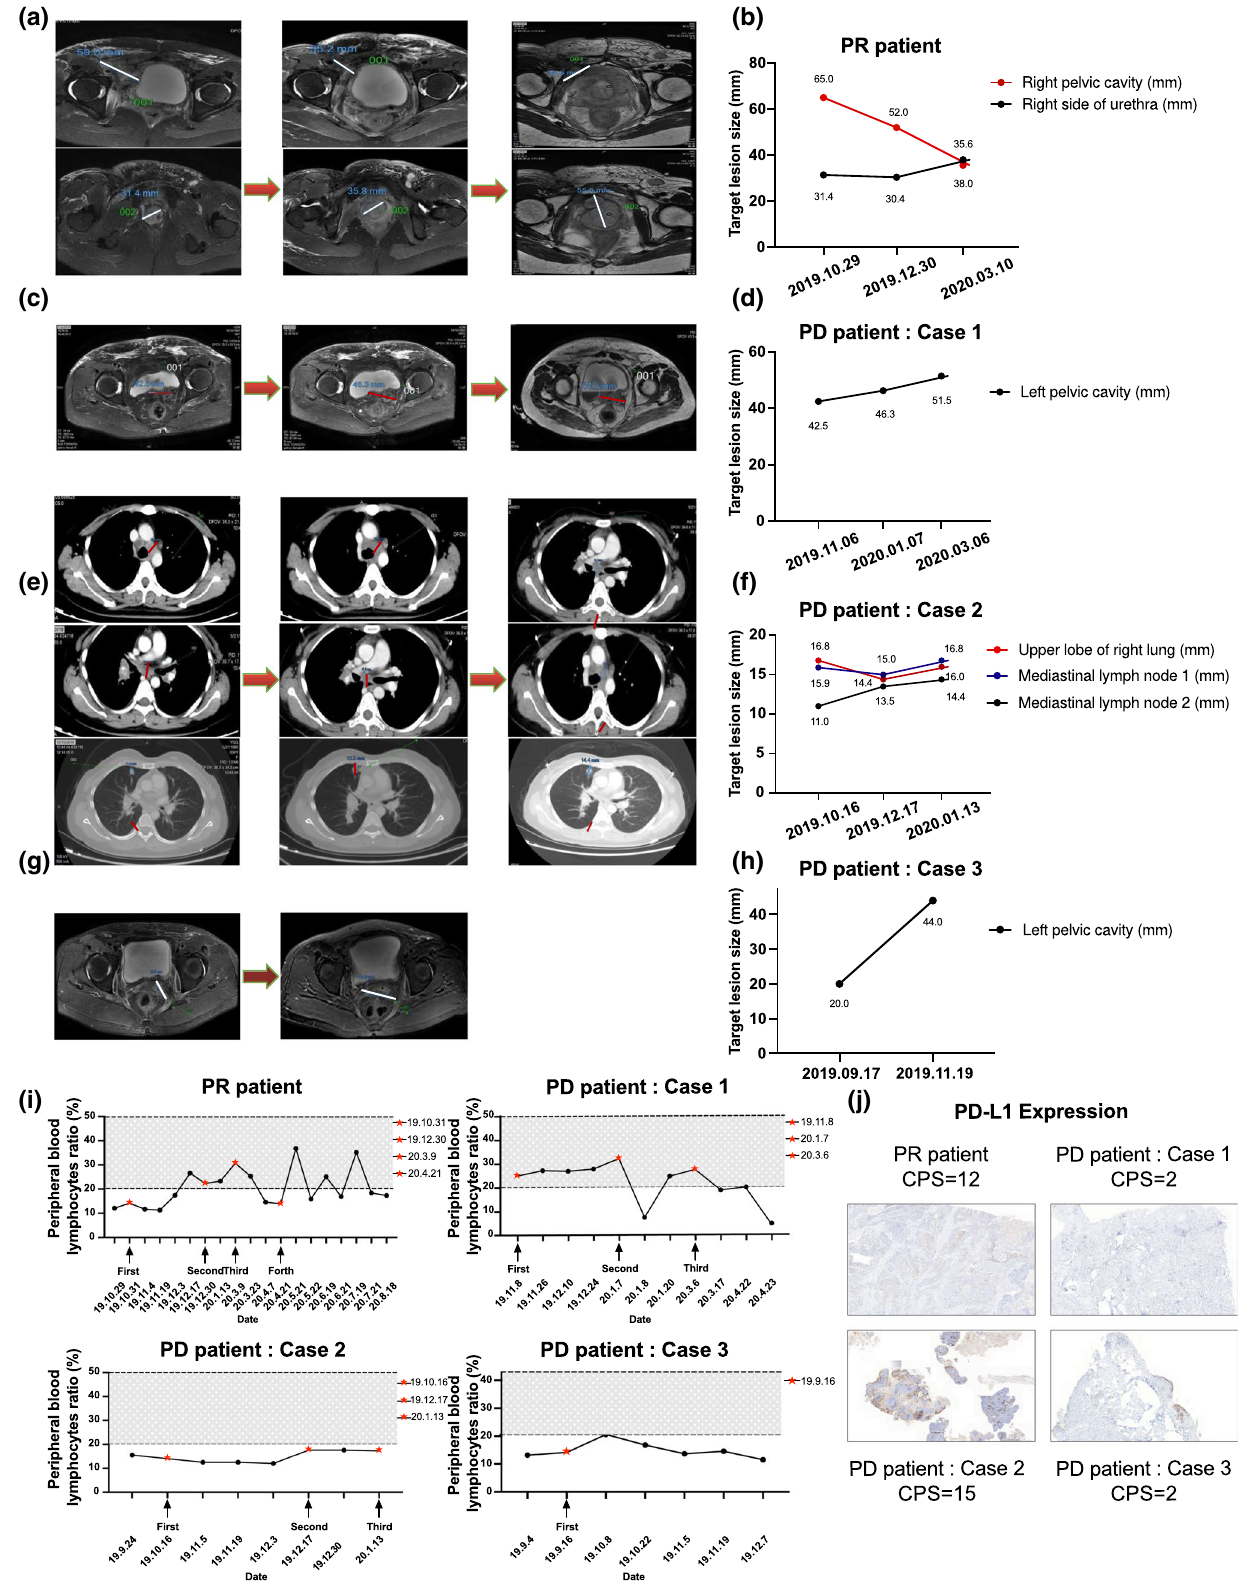
Fig. 2 Detection of clinical indicators of patients. A – H Image changing trend of target lesion size of patients. I Change trend of peripheral blood lymphocyte ratio of patients. J PD-L1 expression of immunohistochemistry staining. The combined positive score (CPS) was used to represent the expression